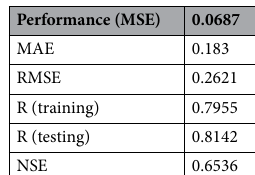
Table 11. Evaluation using LM backpropagation.